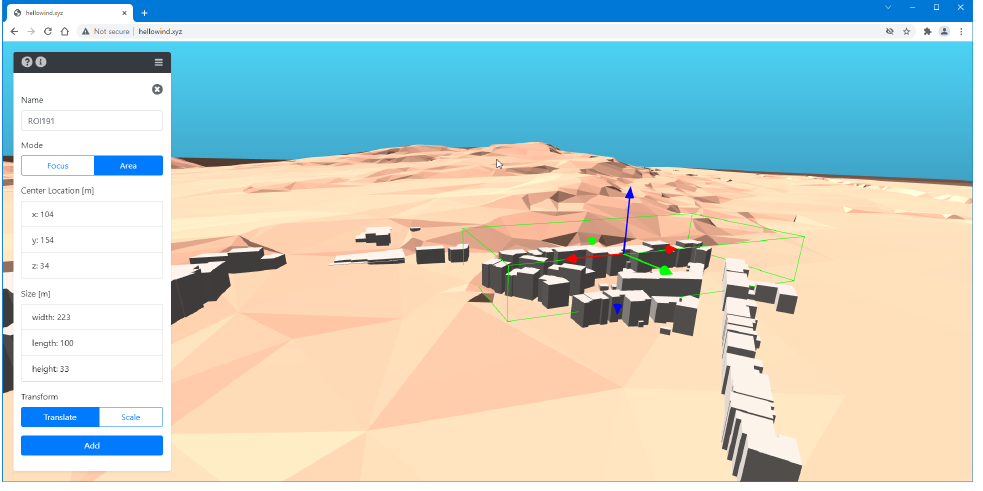
Figure 11. Definition of an ROI in area